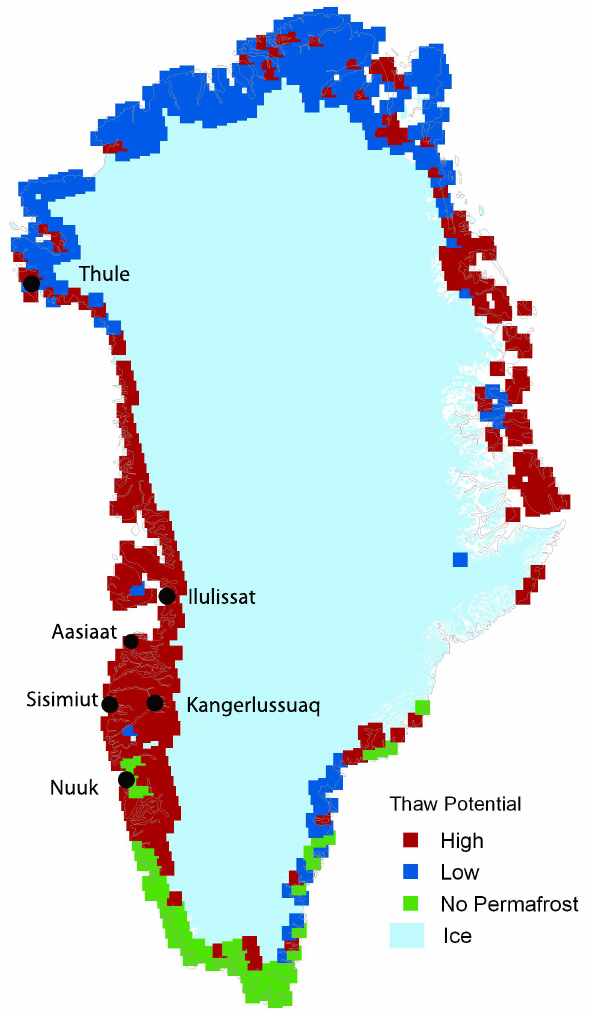
Fig. 6. Permafrost Thaw Potential (PTP) classification for Green- land. High thaw potential coresponds to a PTP value greater than 2.5m. The potential active layer depth increase was calculated by subtracting current sediment active layer depths (1995–2005) from future bedrock active layer depths (2055–2065).